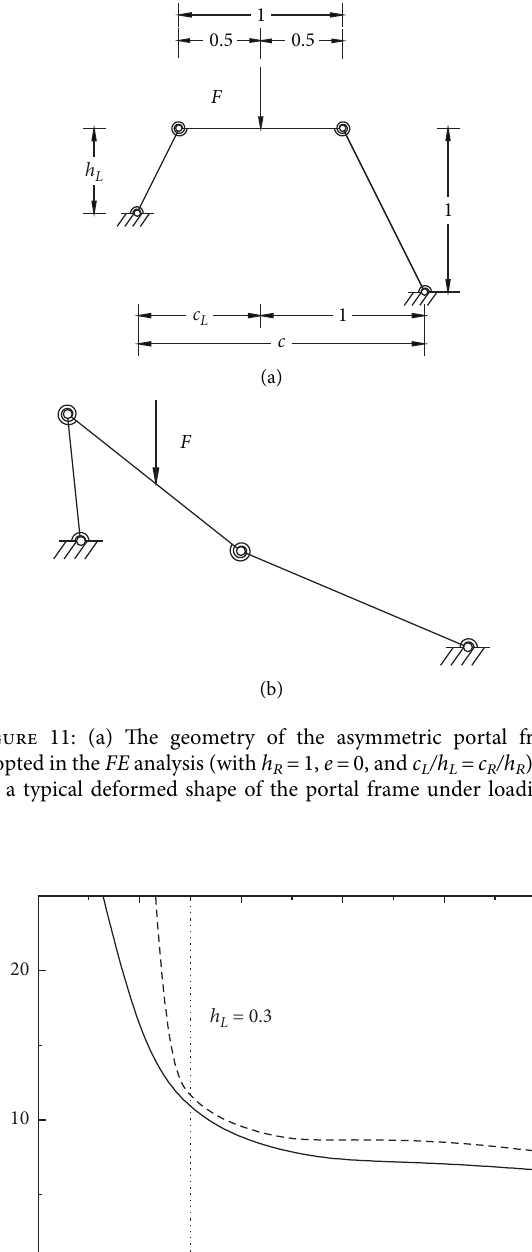
Figure 10: Effect of asymmetry ( c R ≠ c L ) on the snap through load ( F s ) of a portal frame with h R � h L � 1 and e � 0.